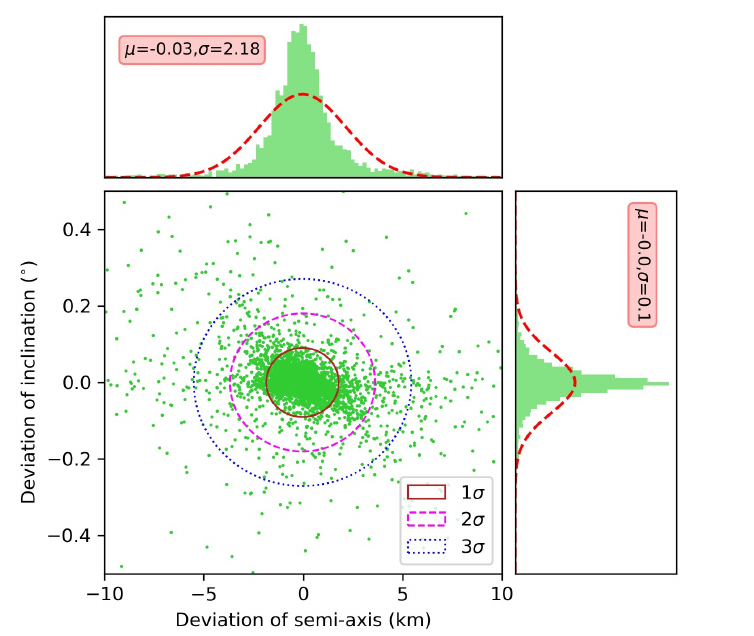
Figure 5. Accuracy of orbit determination with